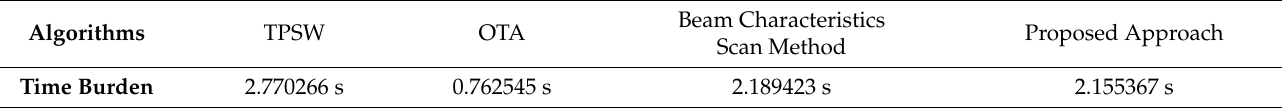
Table 1. Comparison of computational